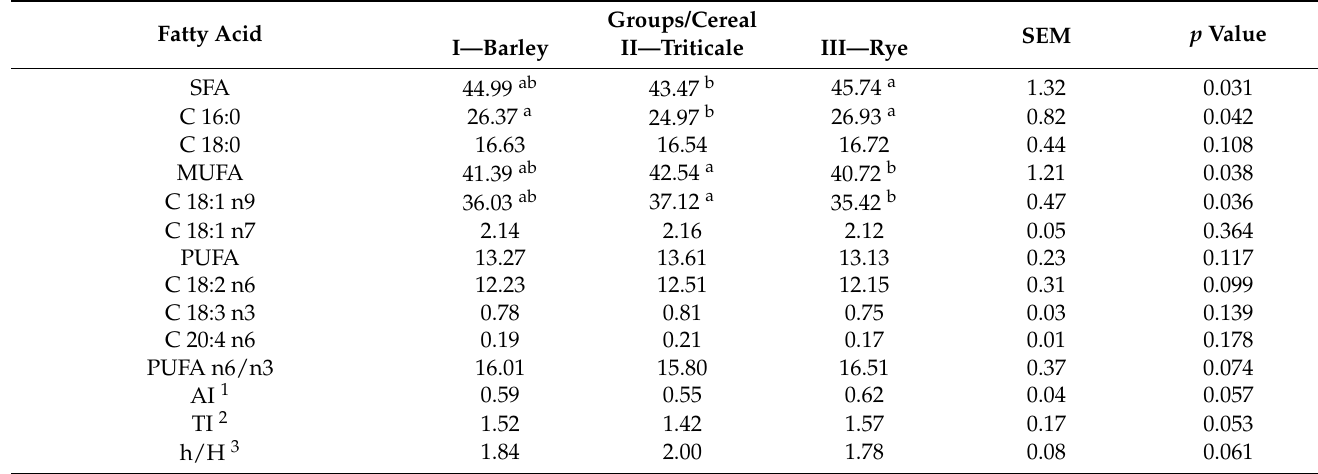
Table 9. Fatty acid composition (% of all estimated fatty acid) and indices of fat dietetic value in backfat adipose